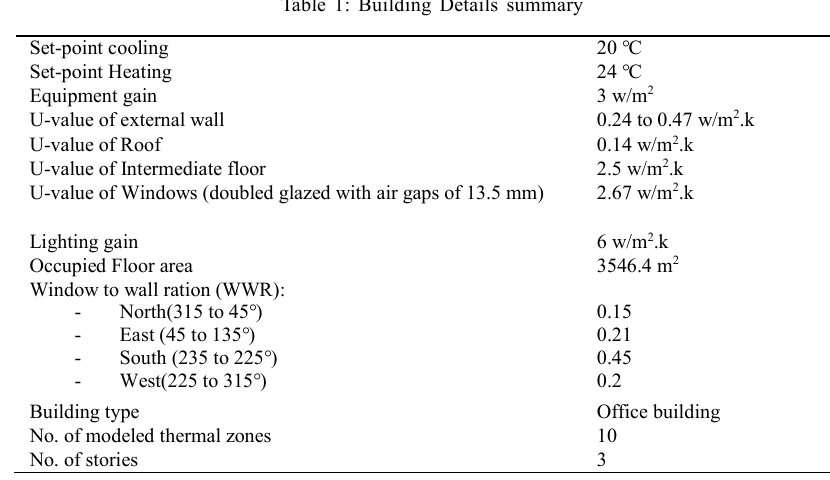
Table 1: Building Details